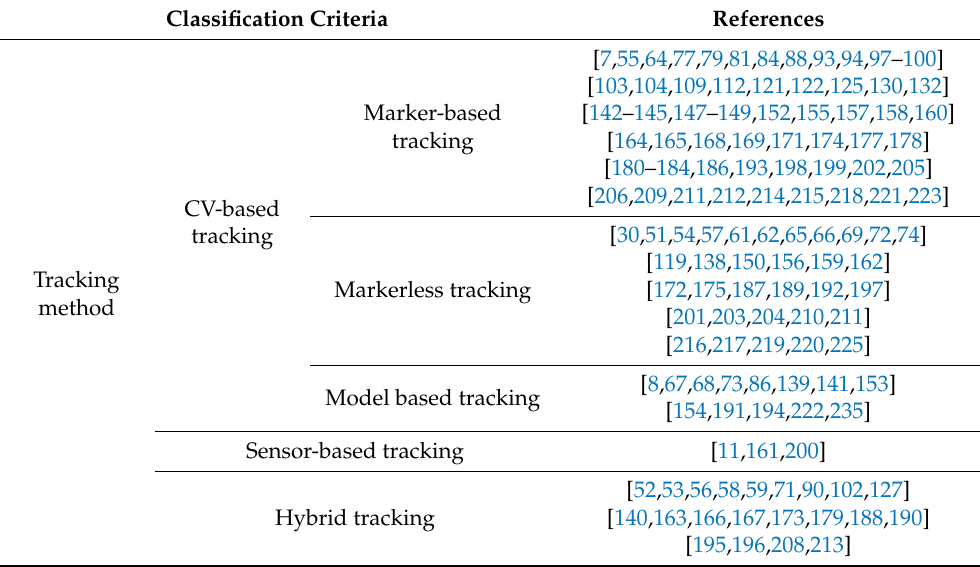
Table 15. Articles on Tracking methods from